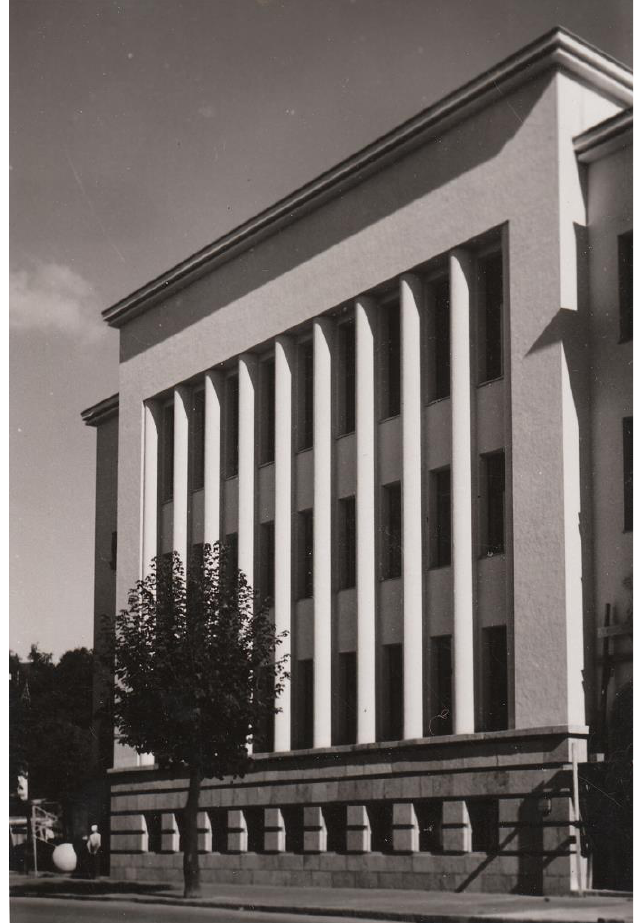
Figure 6. The Chamber of Commerce, Industry and Crafts, designed by architect Vytautas Landsbergis. Photo: Vytautas Augustinas, 1938, source: Lithuanian National Museum (published with permission).